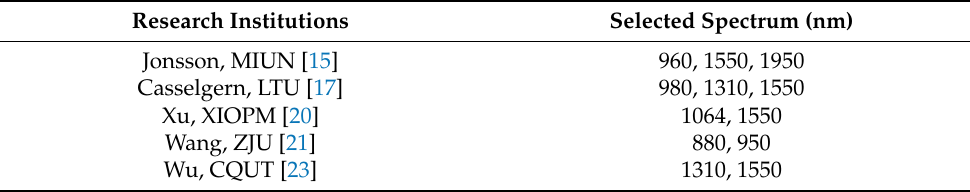
Table 3. Selection of spectra by personnel from various research